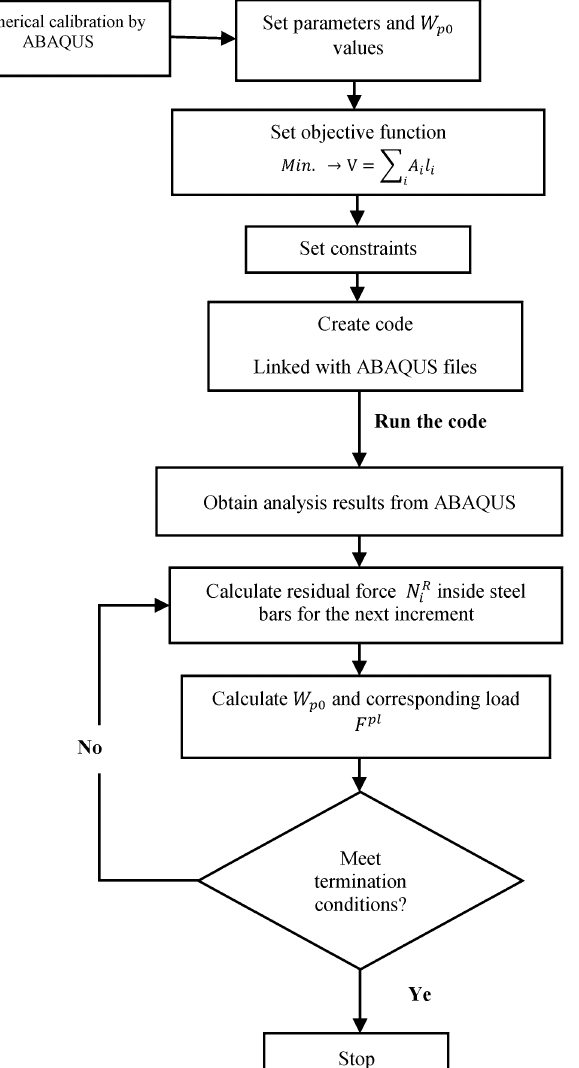
Figure 15. Design optimization process.